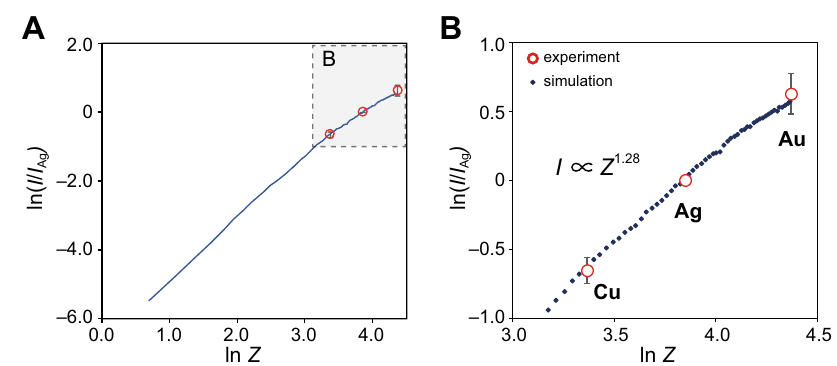
Fig. 2 Dependence of the atomic number ( Z ) of the annular-dark- fi eld (ADF) intensity of single atoms based on simulation and experiment. A The logarithmic plot of Z versus relative ADF intensity ( I/I Ag ) was created based on the simulation (black dot) and the experiment (red circle). B A fi gure showing Panel A extended to the entire atomic number range. The ADF intensity of each atom ( I ) is normalized to that of an Ag atom ( I Ag ) . The error bars represent the averages and the standard deviations of the experimental data. The elements in the simulation ranged from hydrogen ( Z = 1) to gold ( Z = 79).